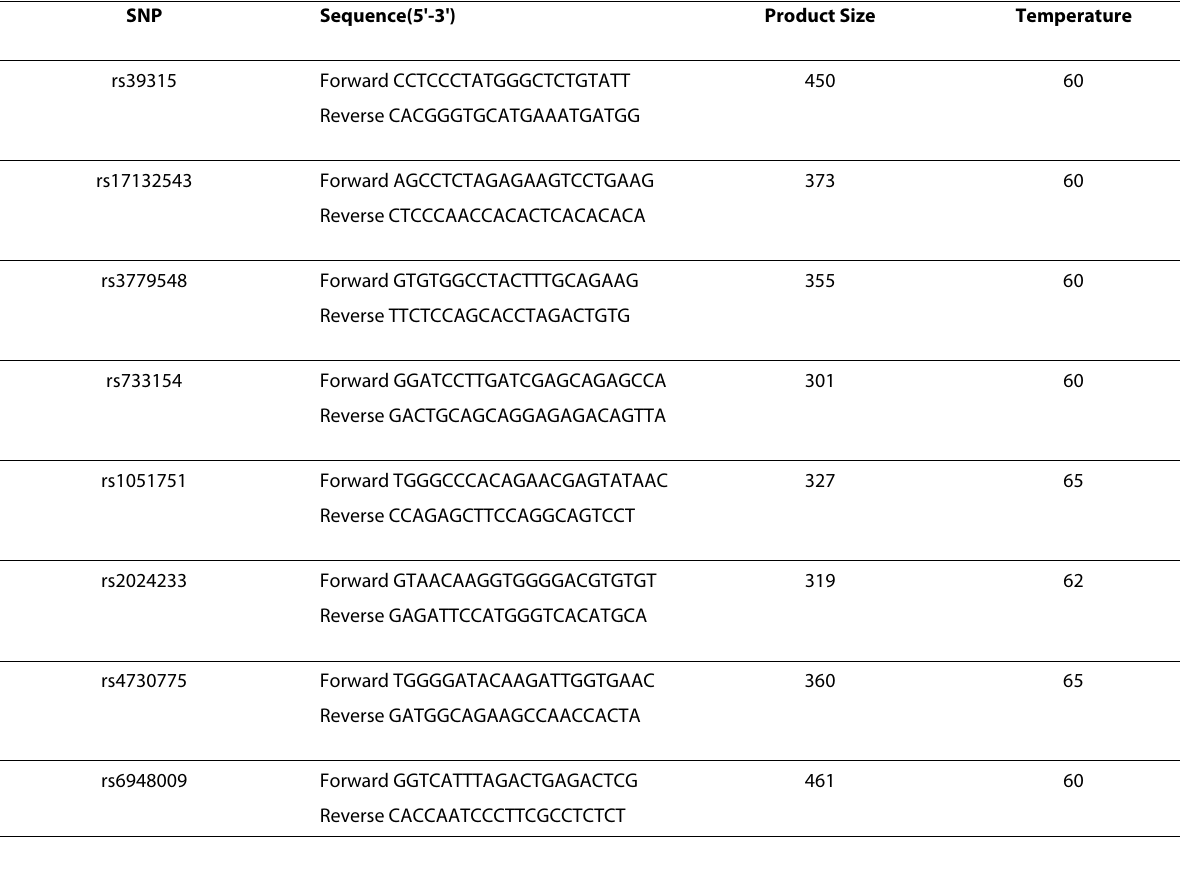
Table 2: Primer Sequences